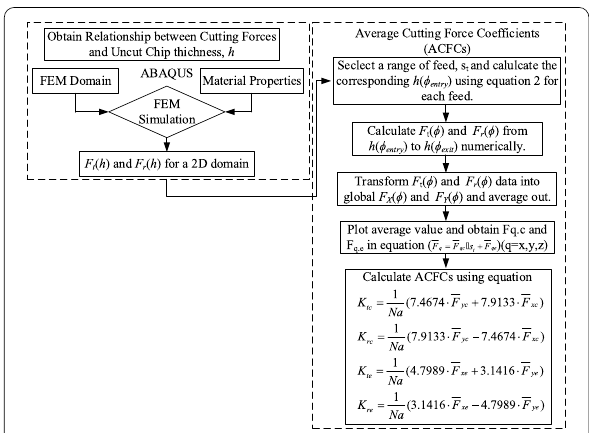
Figure 21 Steps for estimating average cutting force coefficients